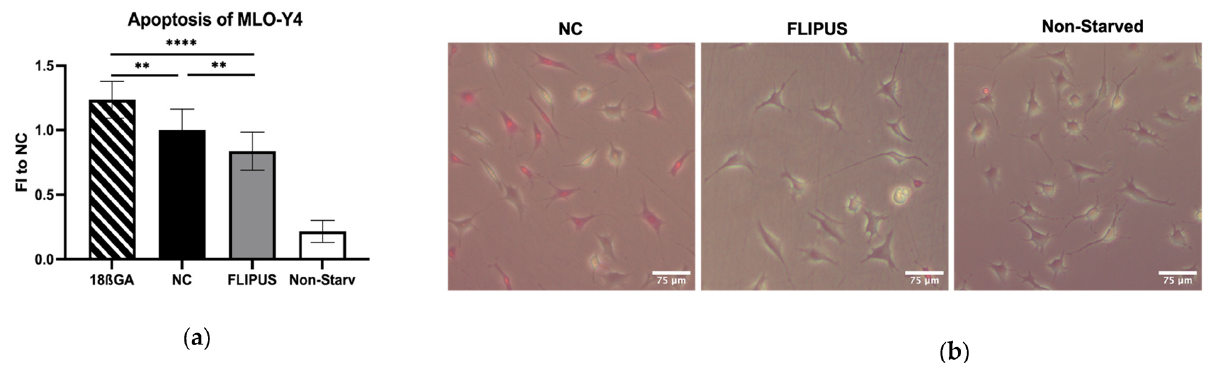
Figure 8. Ten - minute stimulation with FLIPUS mitigates apoptosis of starved MLO - Y4 osteocytes . ( a ) Quantification results of the ApoPercentage TM assay; ( b ) Representative images of the dye - stained negative control (NC), FLIPUS - stimulated and non - starved cells. Pink cells represent dye -